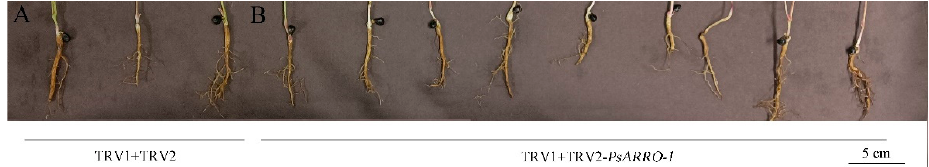
Figure 7. Transgenic Paeonia suffruticosa seedling roots of PsARRO − 1 . ( A ): TRV1 + TRV2; ( B ): TRV1 + TRV2 − PsARRO − 1 . The scale bar is 5 cm.